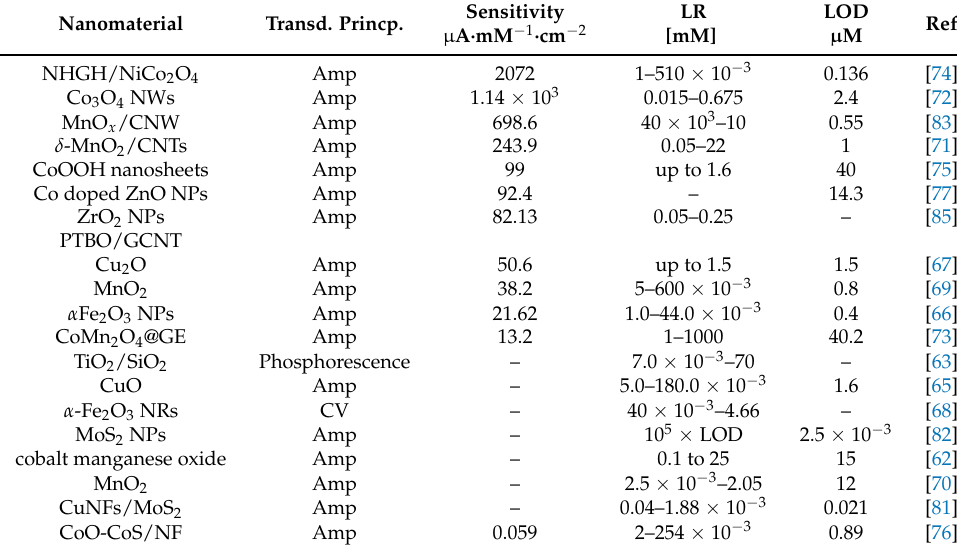
Table 3. Sensors based on metal oxide